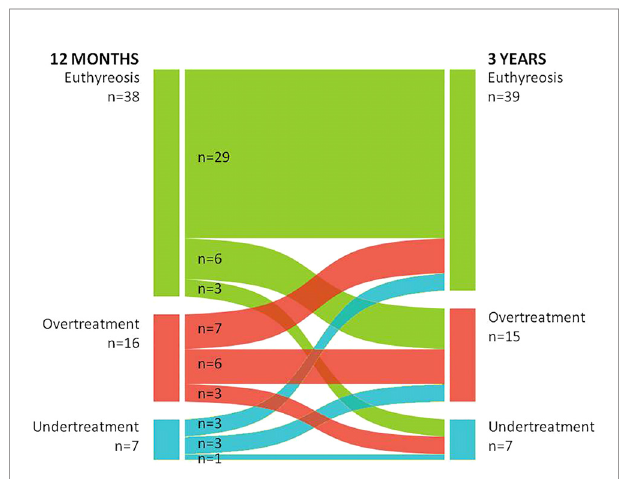
FIGURE 3 | Comparison of the treatment status at 12 months and 3